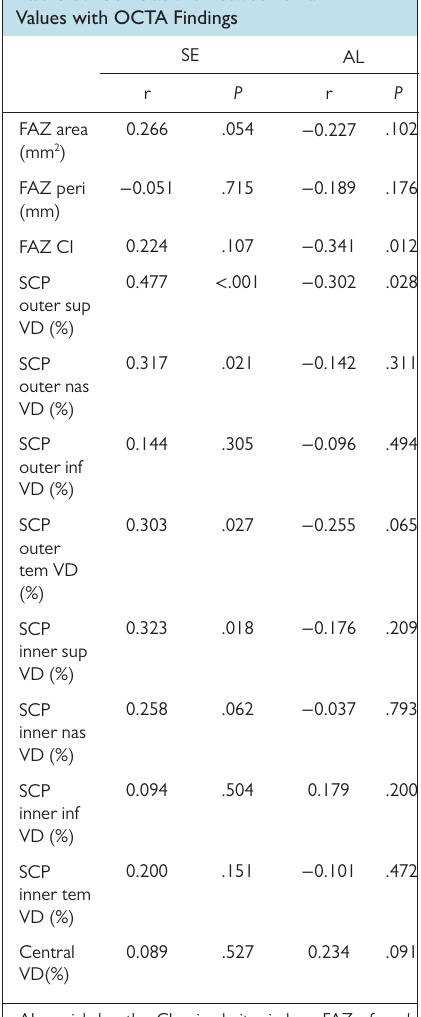
Table 3. Macular Thickness Measurements of the Study Participants Simple Myopia Control